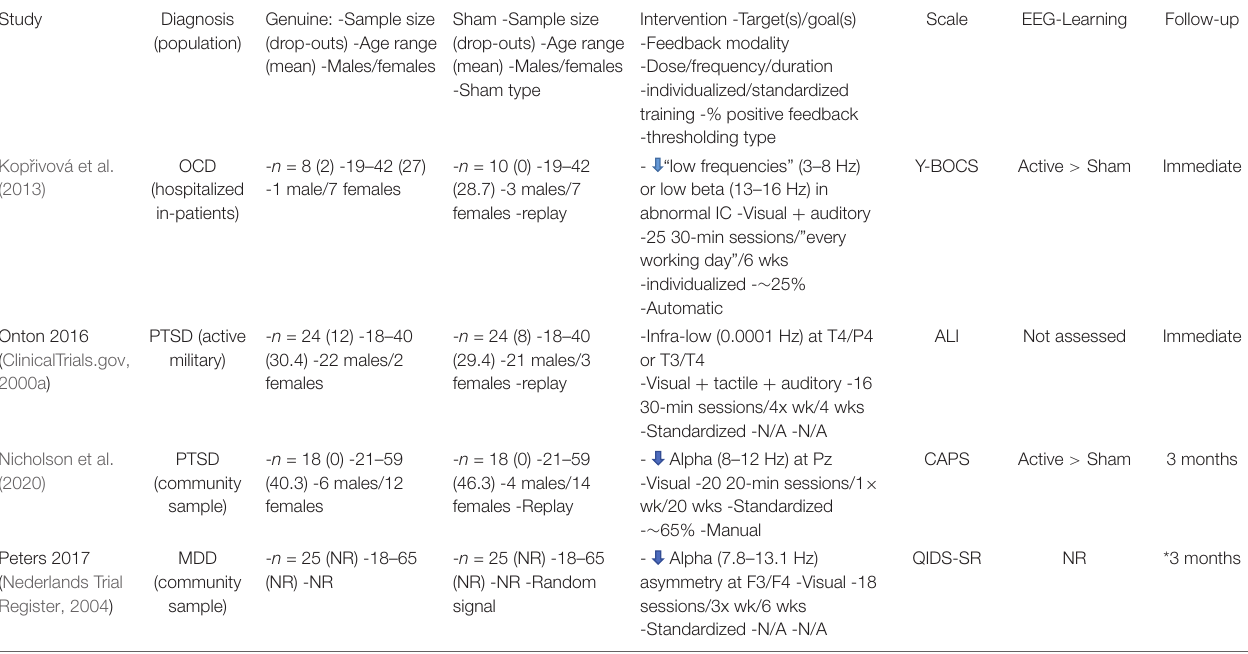
TABLE 2 | Summary of EEG-neurofeedback studies included in this review. Study